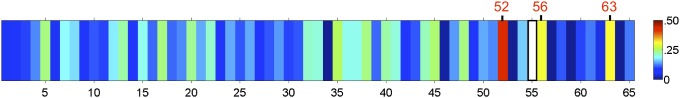
Correlations between ratings on item 55 (white) and all other SRS items.The three items with the highest correlations were items 52 (“Knows when he or she is talking too loud or making too much noise”), 56 (“Walks in between two people who are talking”), and 63 (“Touches others in an unusual way (e.g., he or she may touch someone just to make contact and then walk away without saying anything)”), all of which relate to the concept of social distancing.